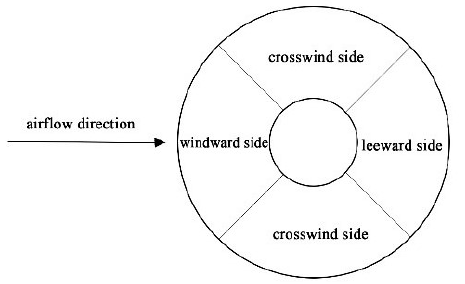
Figure 6. Schematic diagram of the shed division of